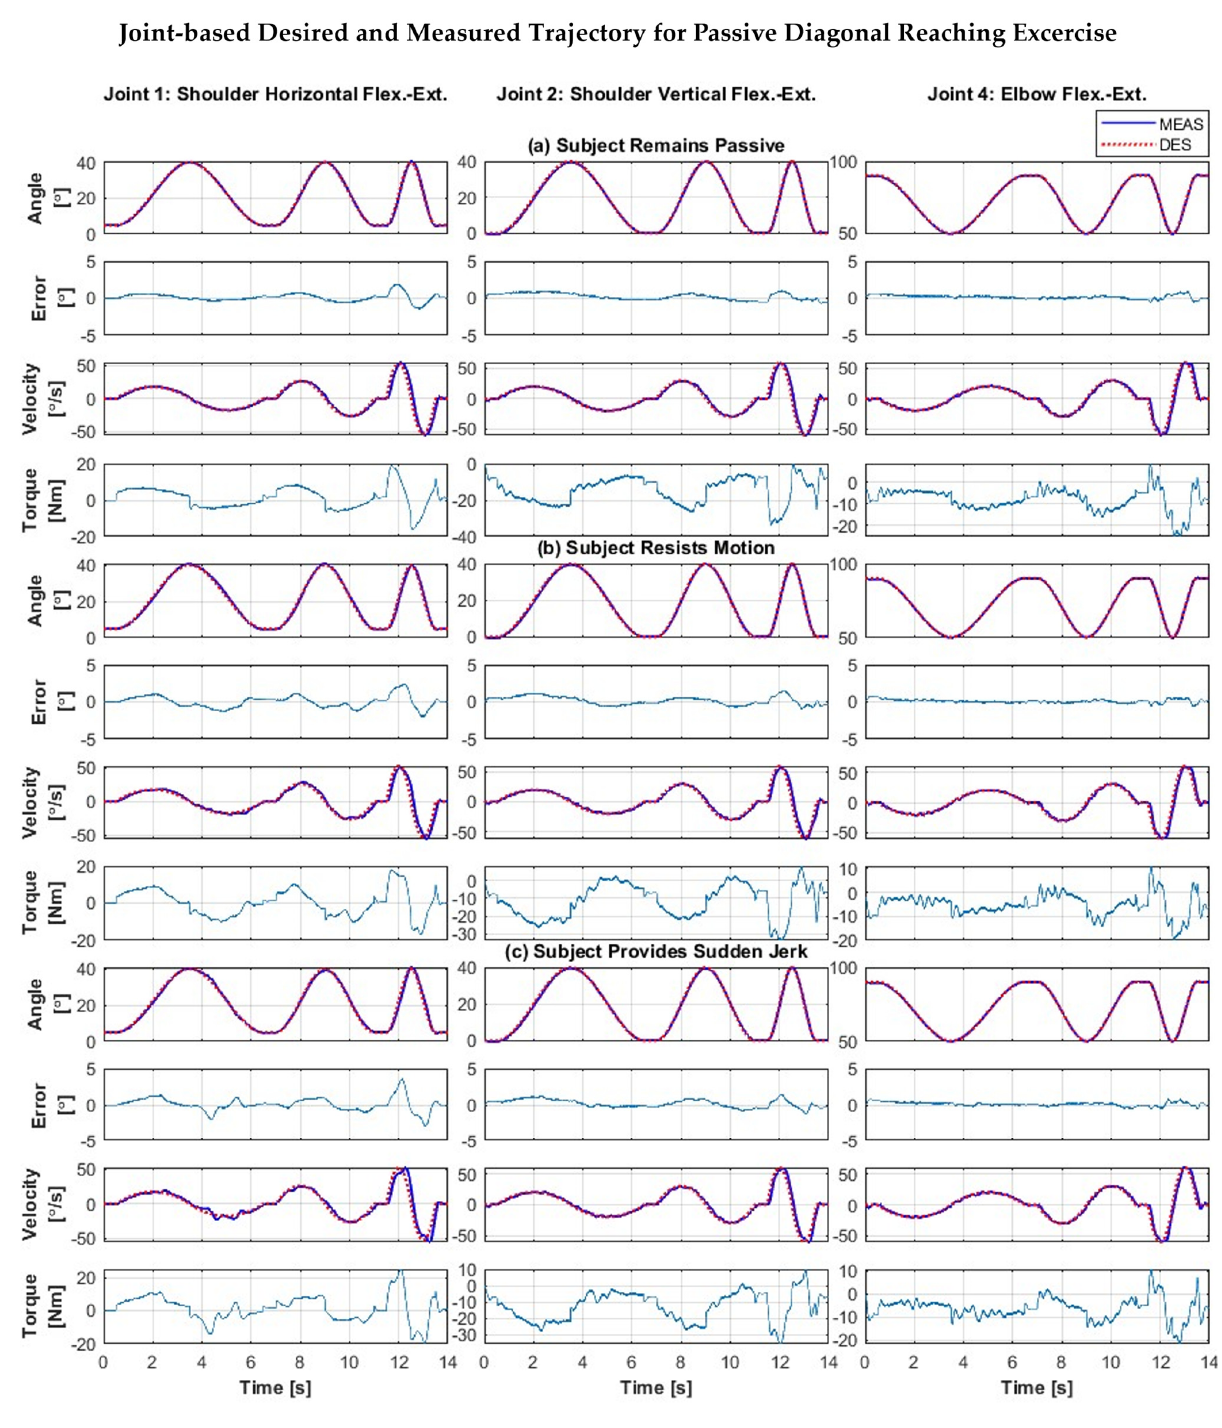
Figure 9. Trajectory tracking during diagonal reaching exercise (combination of shoulder vertical, horizontal, and elbow flexion/extension) of Subject B, while the subject ( a ) remains passive during the exercise motion, ( b ) resists the motion, and ( c ) provides sudden jerk force during the motion.